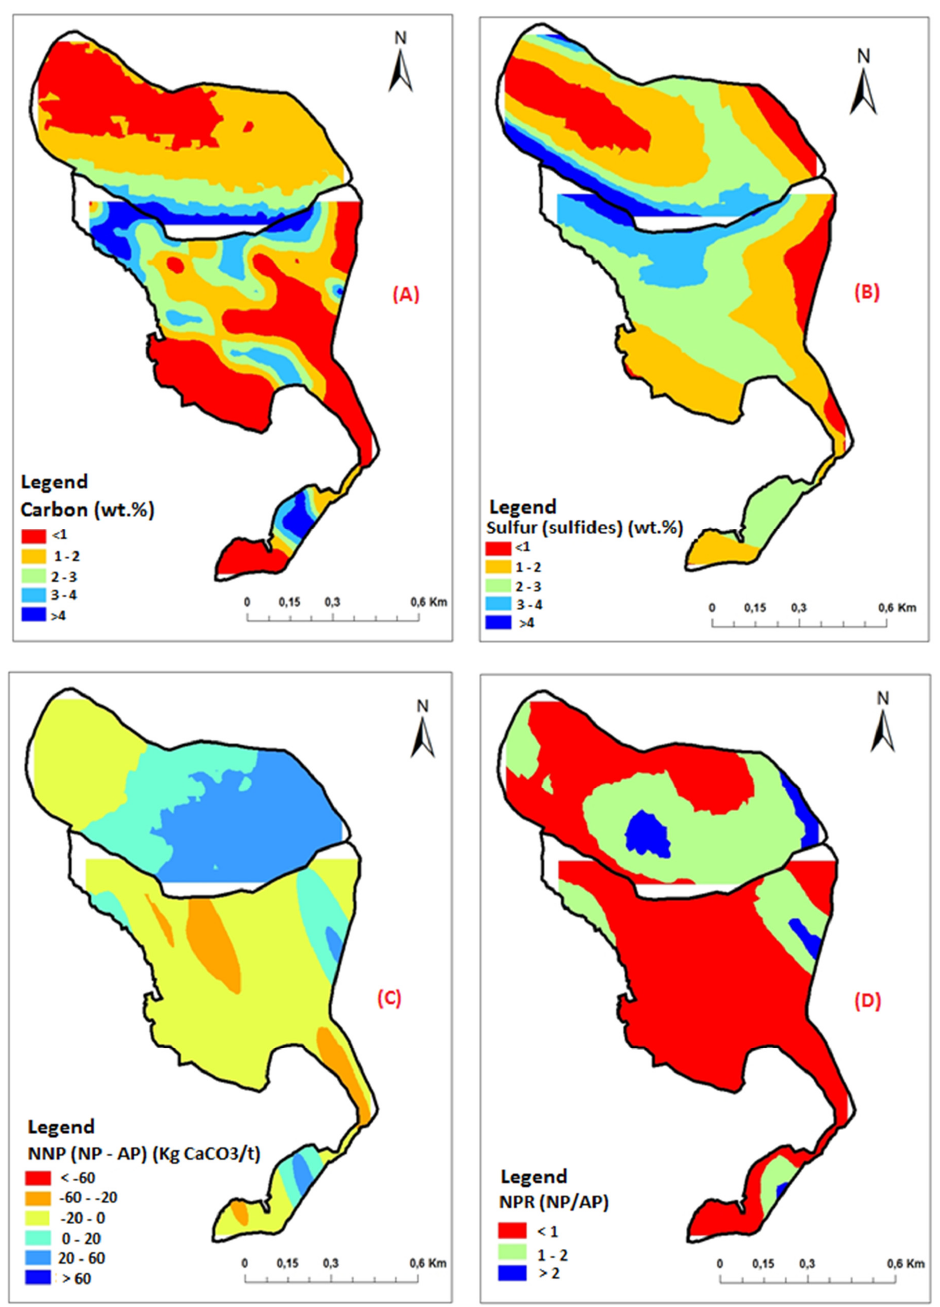
Figure 9. Results of the mapping of: ( A ) C inorganic , ( B ) S sulfide , ( C ) NNP, and ( D ) NPR. The S sulfide distribution, which corresponds to the residual acid potential of oxidized tailings, is illustrated in Figure 9B. This distribution can be compared to that of the total C inorganic . The eastern portion of the southern zone and the western portion of the northern zone are characterized by high sulfide depletion (<1 wt.%). In other locations, the S sulfide content (mainly pyrite) is higher than 2 wt.%. In the southern zone, the S sulfide content increases from south-east to north-west, while in the